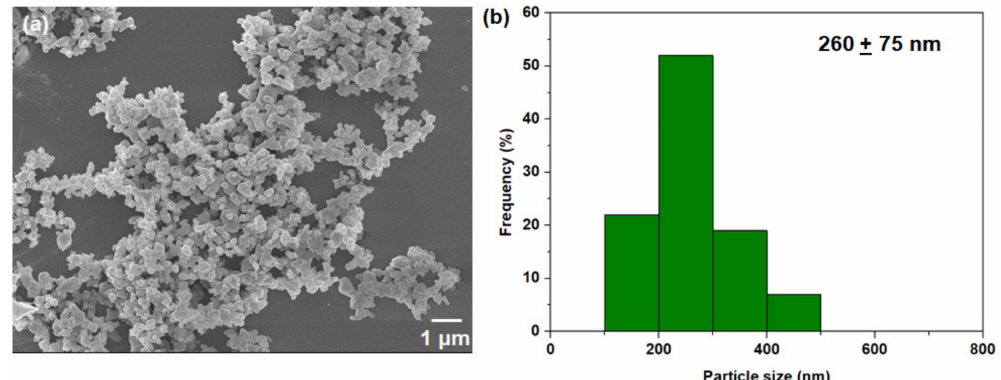
Figure 3. ( a ) FESEM image of nanocrystal HKUST-1; ( b ) Particle size distribution of nanocrystal HKUST-1. The mean and standard deviation are included in the